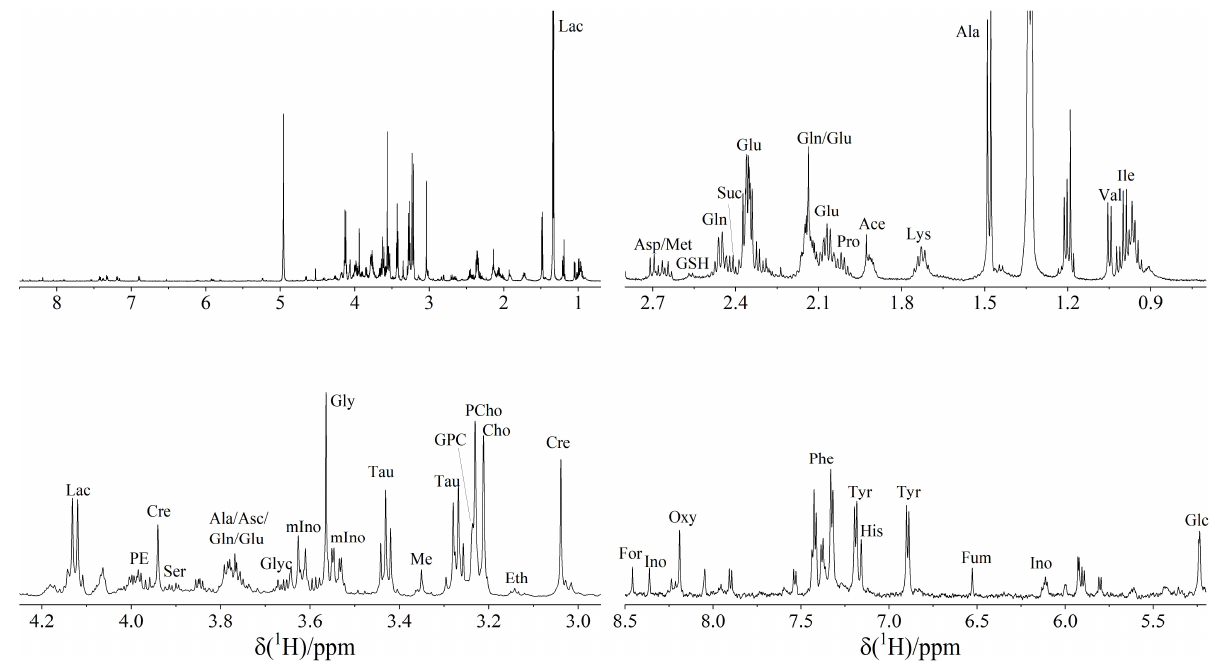
Figure 2. Representative 1D HRMAS 1 H-NMR spectrum of a B2 thymoma measured at a tissue temperature of 4 ° C and referenced to the internal standard, TSP (3-trimethylsilylpropionic-2,2,3,3-d 4 - acid sodium salt), full spectrum (upper left) and three expansions. Abbreviations: Ace: acetate, Ala: